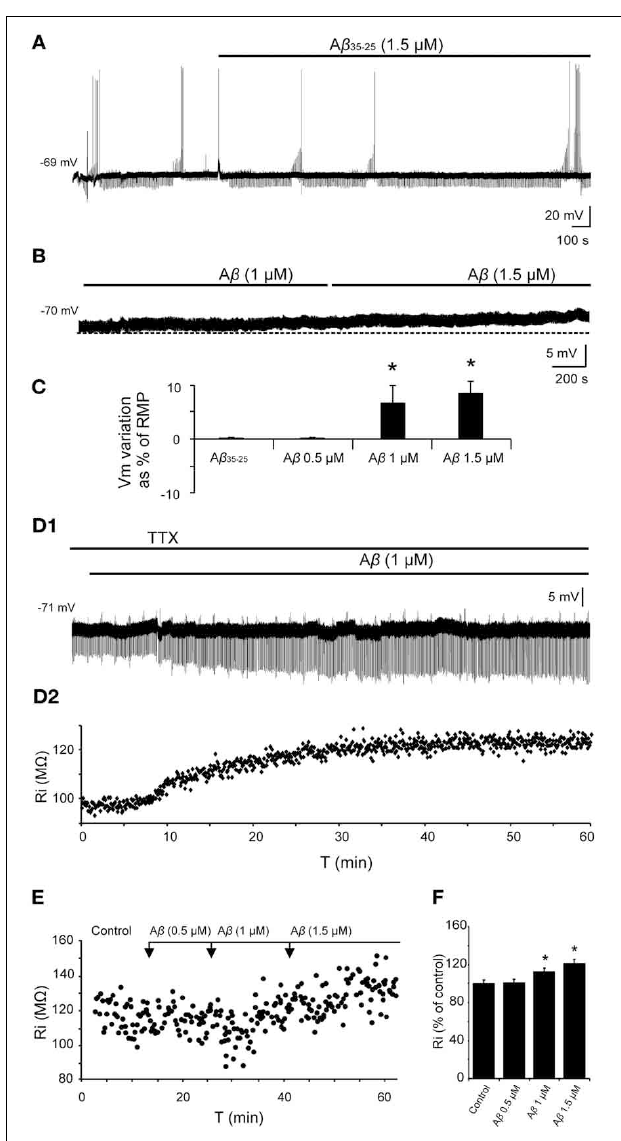
FIGURE 4 | Effects of A β 25 – 35 on membrane potential and Ri of CA3 neurons. (A) Recording of a CA3 pyramidal neuron during the perfusion of the reverse sequence of the peptide, A β 35 – 25 , used as negative control ( n = 4). (B) Depolarization of membrane potential induced by perfusion of A β in a recorded pyramidal CA3 neuron ( n = 10). (C) Plot of the membrane potential variations as a percentage of resting membrane potential (RMP). Perfusion of A β 35 – 25 1 μ M or A β 25 – 35 0.5 μ M did not induce any significant change in the membrane potential or Ri. A β 25 – 35 higher concentrations induced the cells to depolarize (1 μ M; 6 . 8 ± 3 . 2 %, n = 4; 1.5 μ M, 8 . 6 ± 2 . 2 %, n = 10). (D1) Time course of A β effects on Ri in a CA3 pyramidal neuron after perfusion with TTX. The membrane potential was held